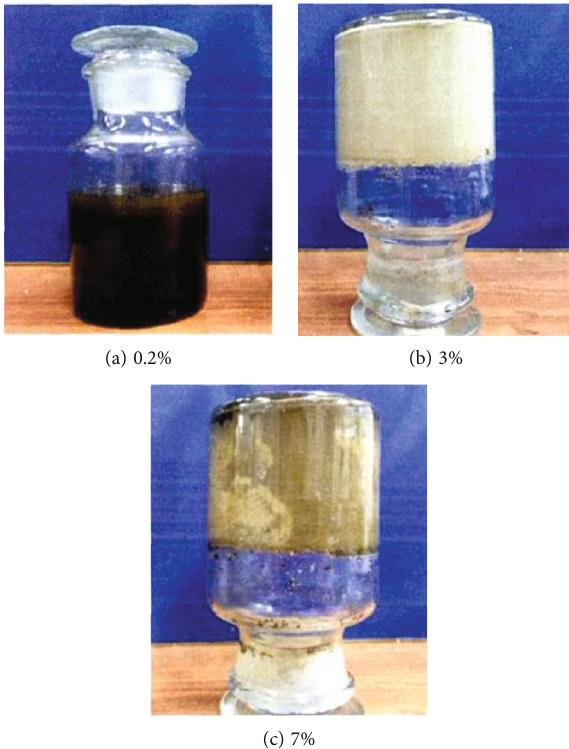
Figure 11: Performance of the gel under di ff erent tannin concentrations.